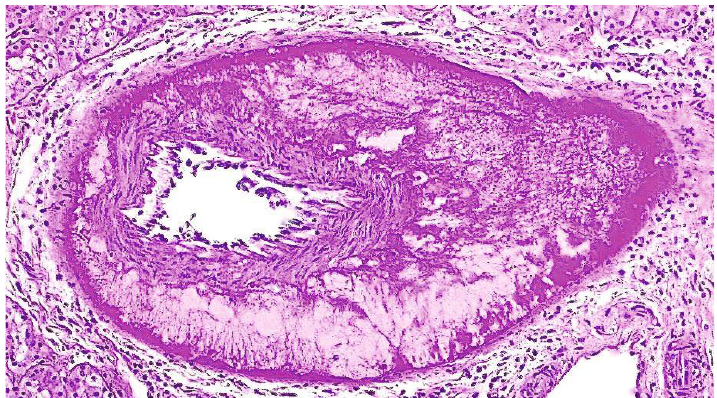
Figure 9: Segmental arterial mediolysis injurious phase. Pig renal artery showing a circumferential separation of the outer media from the adventitia. An edematous tear space containing fi brin strands outwardly pushes the adventitia away from the media. PAS stain × 100 (adapted with permission from Veterinary Pathology 52(6), copyright 2015, Sage Publications Inc.).